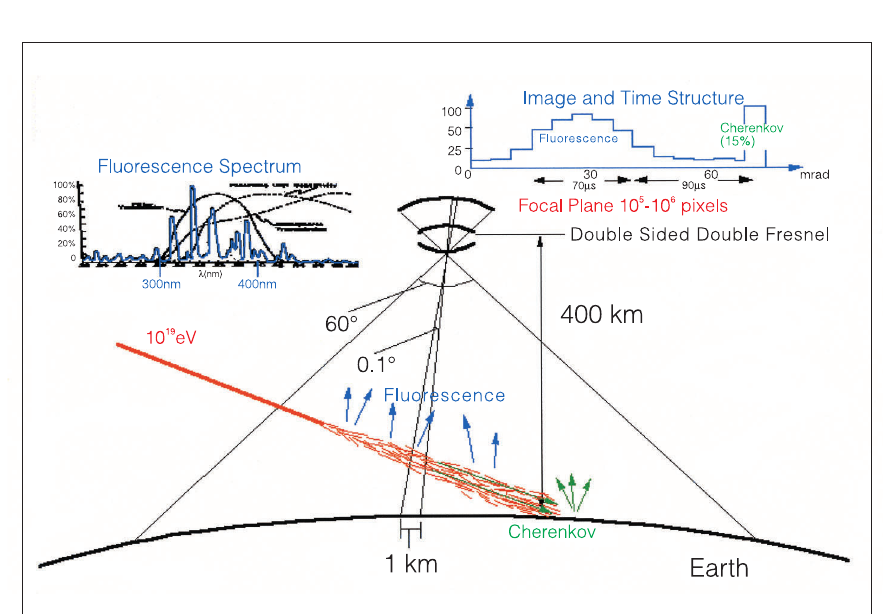
Fig. 6. Observation of EAS from